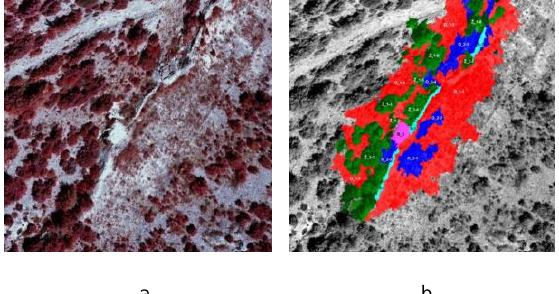
Figure 5. a) The cut part of the RGB infrared image (RMK) of the determined position and b) the presentation of the stone bunker 3 (pink), dry stone wall (light blue) and the pattern of 3 types of the surrounding area (red, dark blue and green) on the image of the green (G) channel